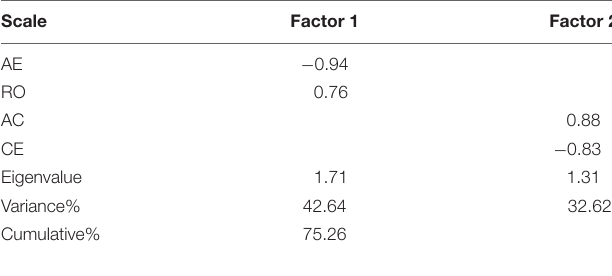
TABLE 2 | Scale intercorrelations of Kolb’s (1985) Learning Style